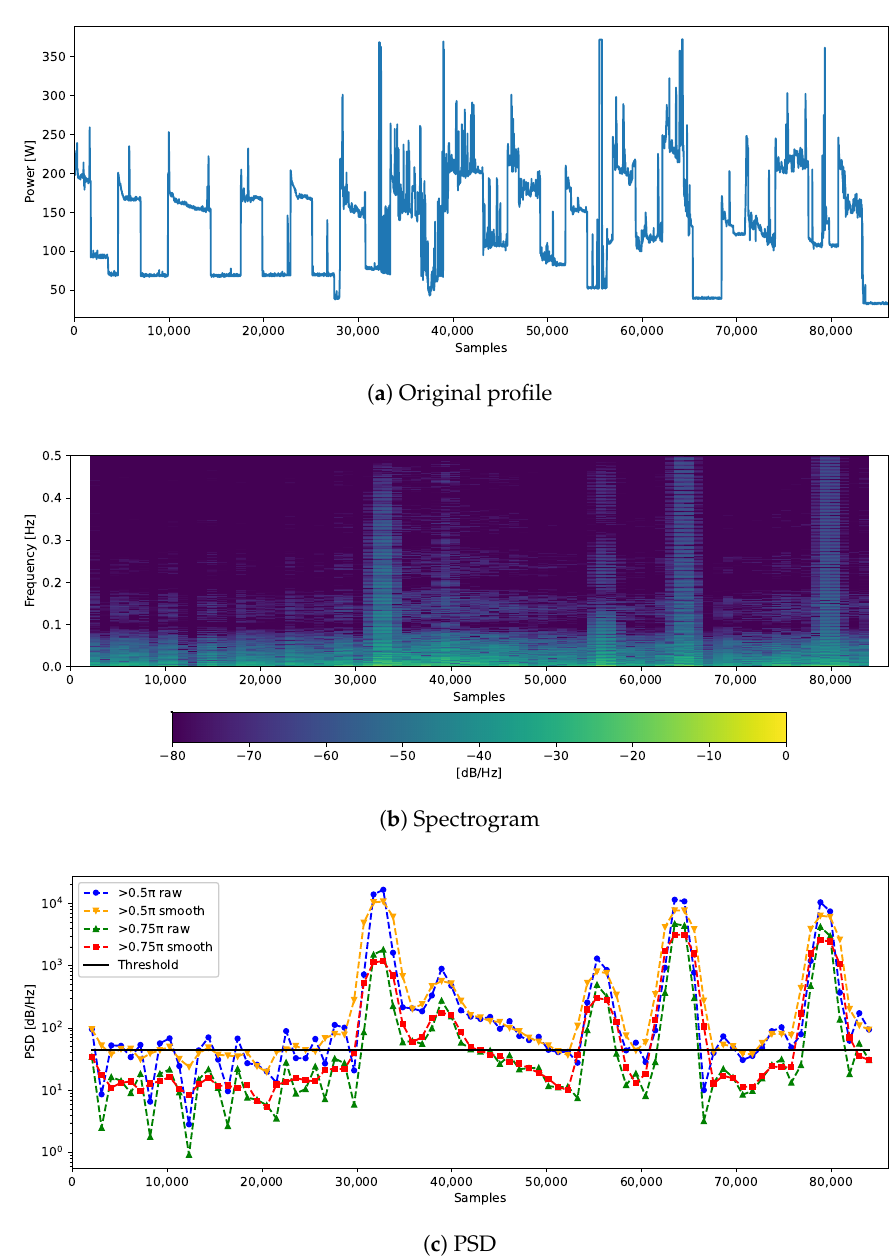
Figure 5. The application process of the frequency selective (FS)